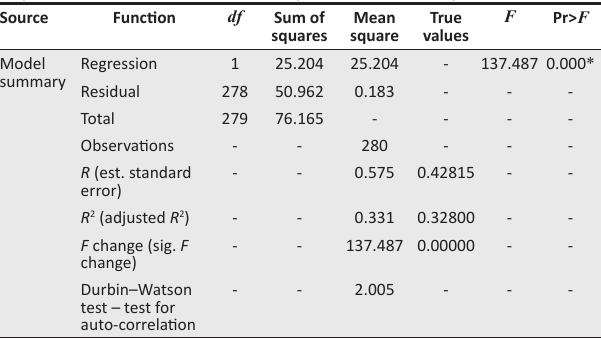
TABLE 9: Simple linear regression model fit and summary for knowledge acquisition on small and medium enterprises’ innovation